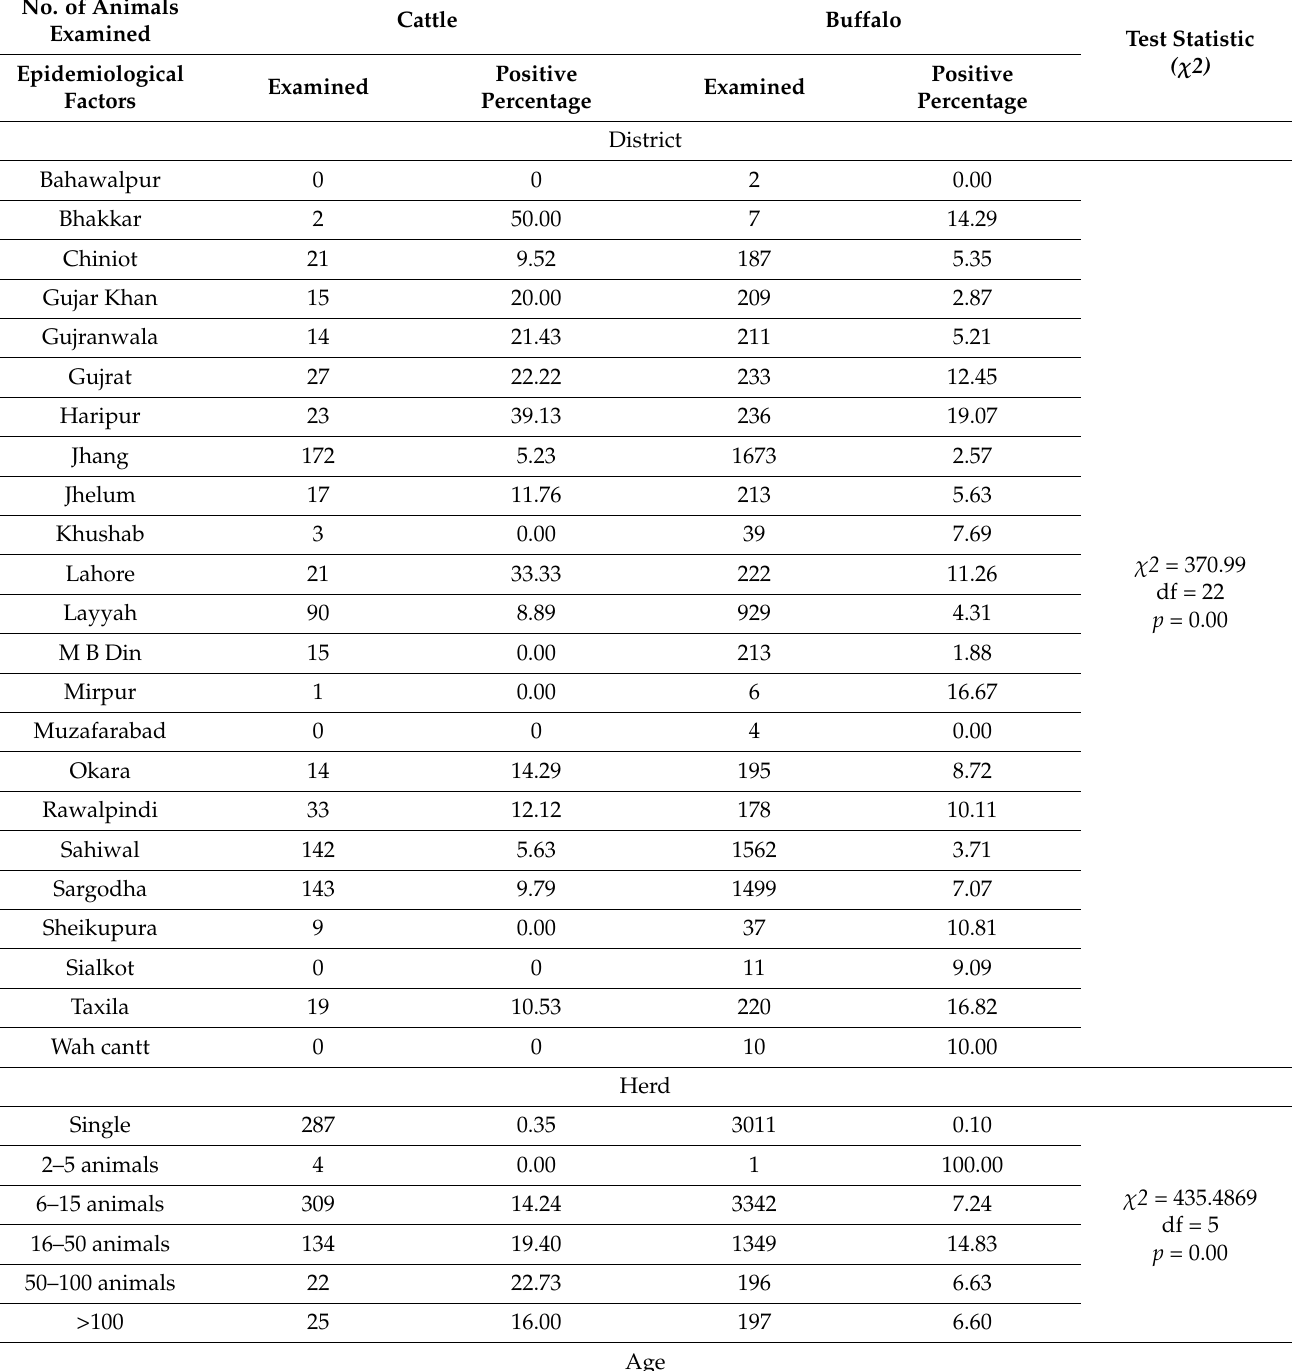
Table 1. Host factors and the related infection rate of cattle and buffaloes seen at the slaughterhouses in Rawalpindi